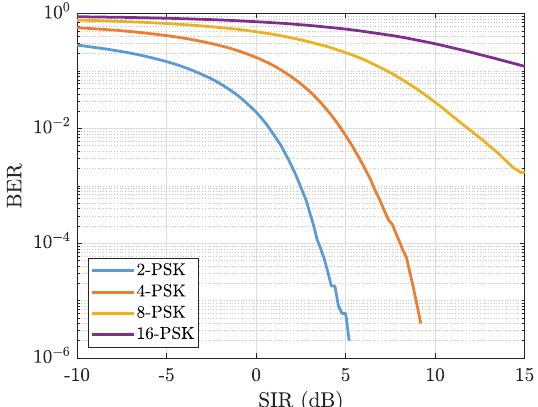
Figure 7. Alamouti 2 × 2 with the presence of the general interferer. Bit error rate (BER) as a function of the signal to interference power ratio (SIR), for different modulation orders 2, 4, 8, 16–PSK and SNR = 15